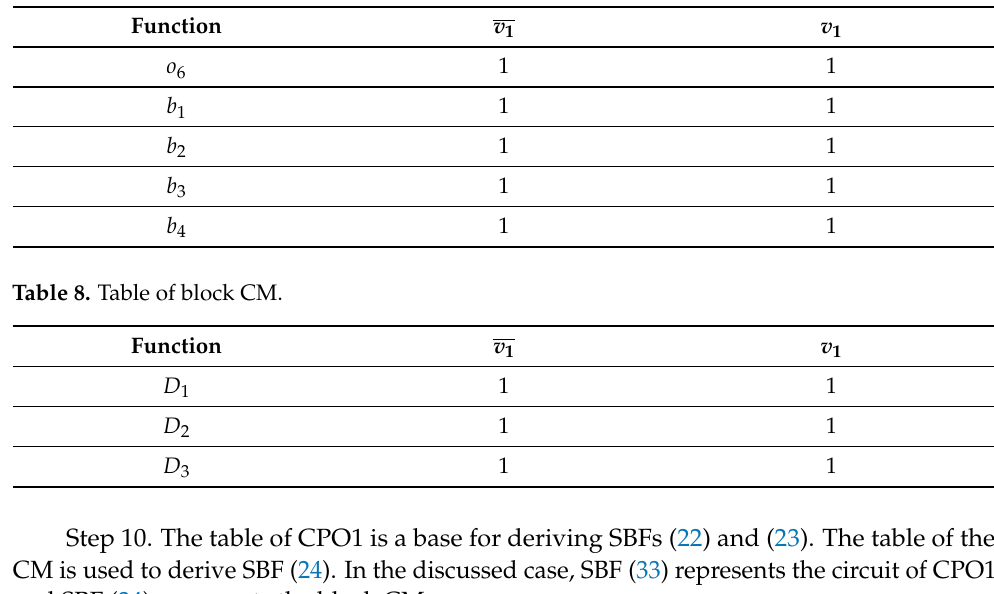
Table 7. Table of block CPO1. Function v 1